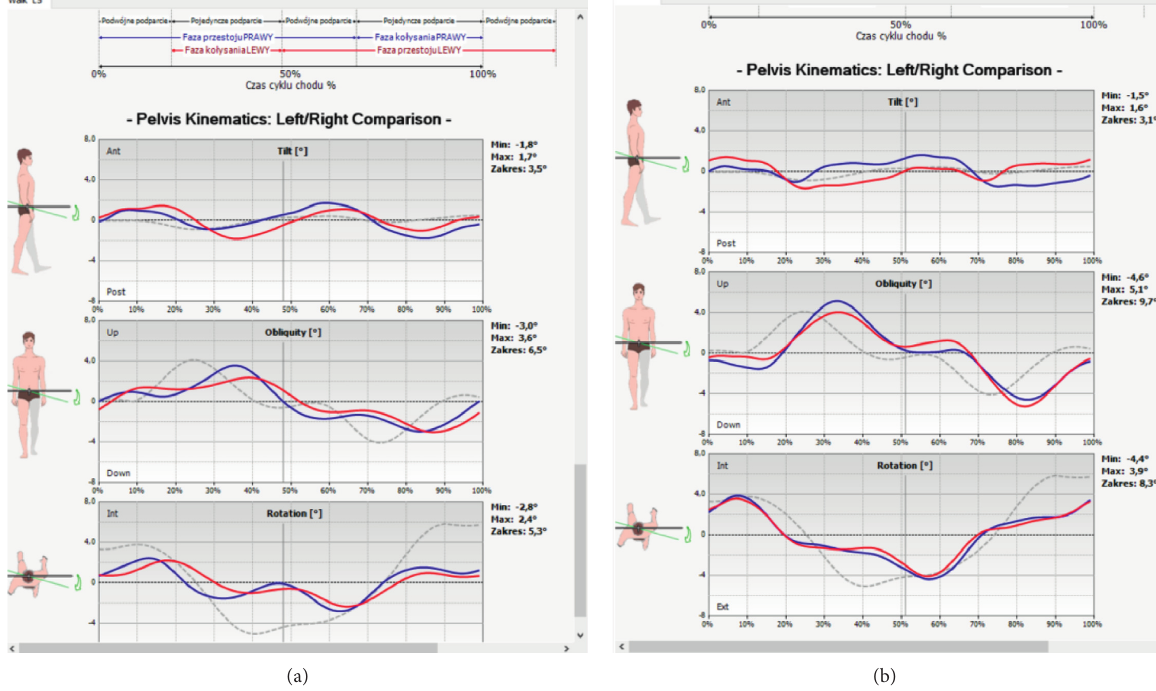
Figure 8: (a) The result of the pelvic mobility test and angle of lordosis (while standing) before repositioning the mandibular head in the articular fossa and stabilizing the condylar process with a temporary silicone occlusive splint in an exemplary patient. (b) The result of the pelvic mobility test and angle of lordosis (while standing) after repositioning the mandibular head in the articular fossa and stabilizing the condylar process with a temporary silicone occlusive splint in an exemplary